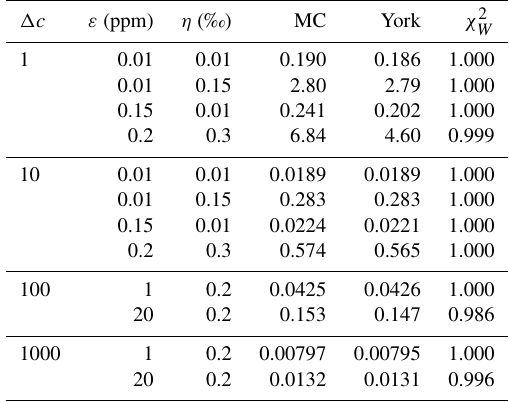
Table 3. Monte Carlo (MC) and York estimates of the error in the isotopic source signature retrieved from an individual Keeling plot, in units of ‰. The mean goodness of fit χ 2 ensemble is also shown.